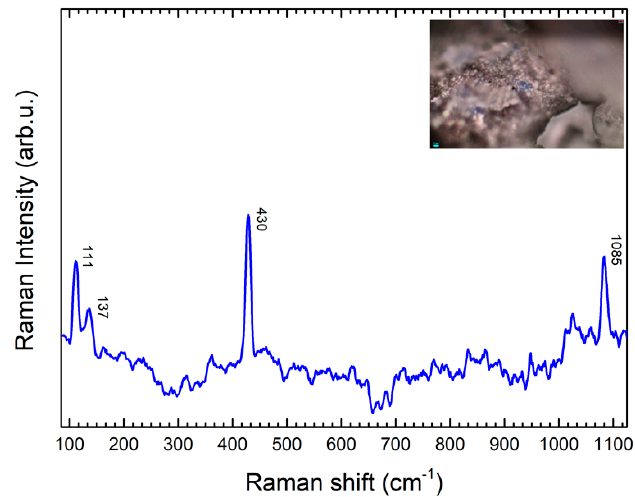
Figure 4. Raman spectrum obtained on a scalpel sample from the D1 area, showing the characteristic peaks of Egyptian Blue.